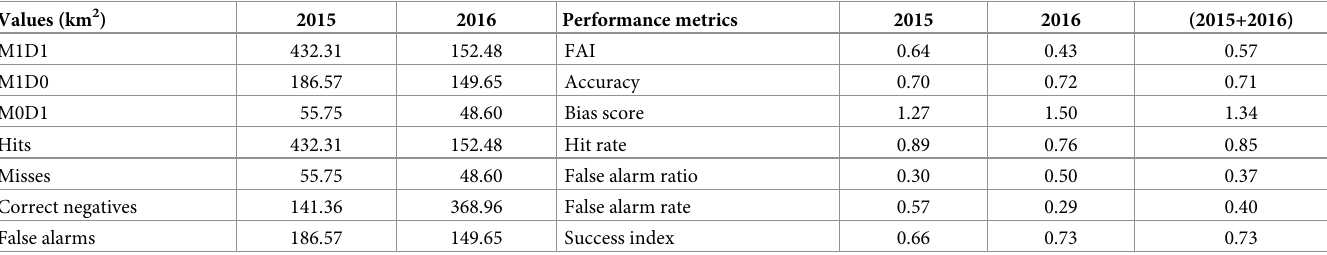
Table 3. Summary of the modeled and satellite-observed inundation results and the model performance metrics. Values (km 2